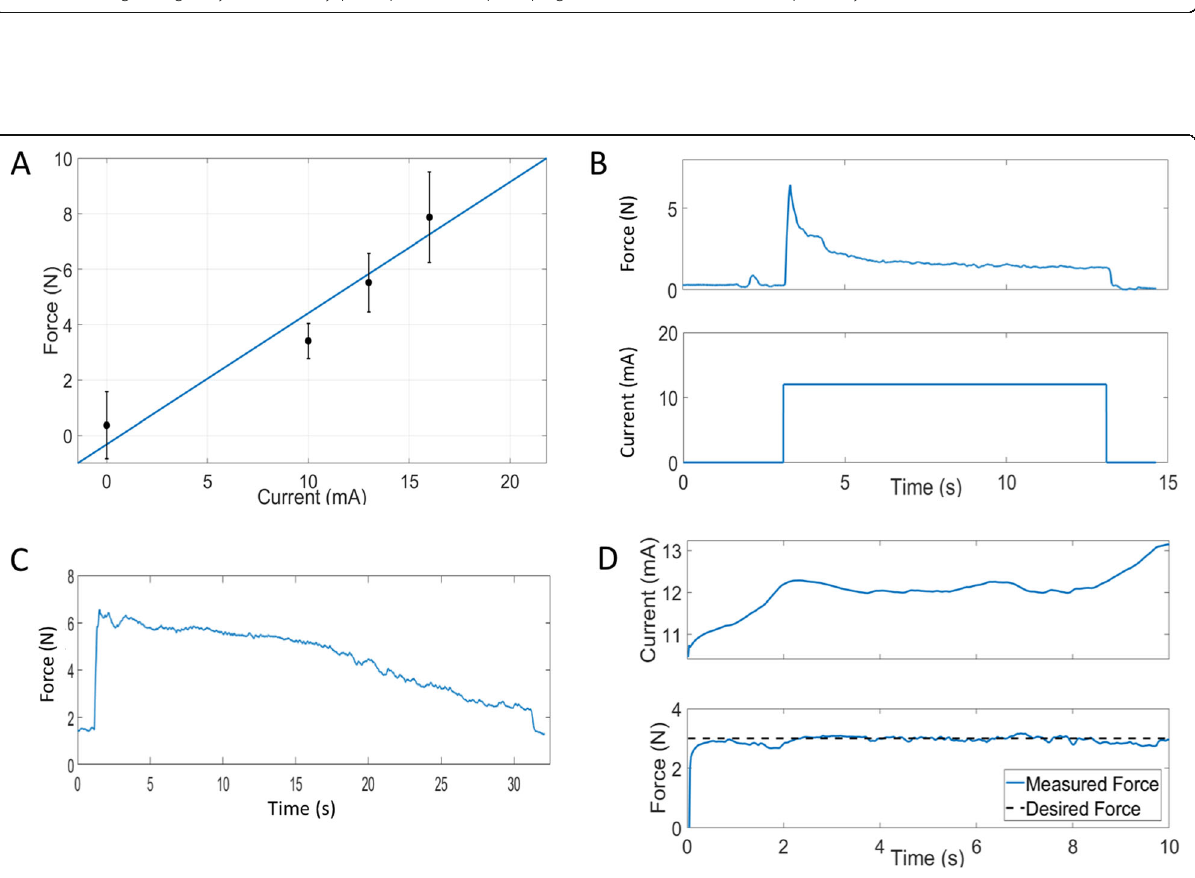
Fig. 3 Textile-based electrodes in sleeve form. ( a ) Natural hand position when stimulation is off ( b ) Stimulation turned on, evoking index finger flexion and pinch-type movement (subject NMES05). ( c ) and ( d ) Stimulation evoked a cylindrical grasp with sufficient force to hold a full (750 mL) water bottle against gravity in two study participants with quadriplegia (NMES04 and NMES05 respectively)